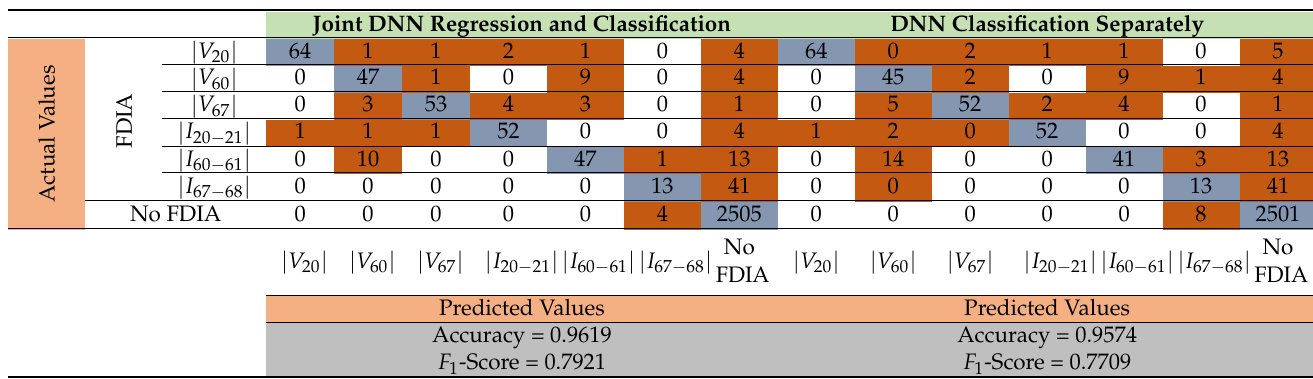
Table 7. Confusion Matrix Showing Bad Data Detection Results and Accuracy Values Obtained Using the Proposed Method and the Binary Classification-only DNN Model when N a = 876 ( 10% ) , and z a = ∼ N ( µ z , σ z ) .